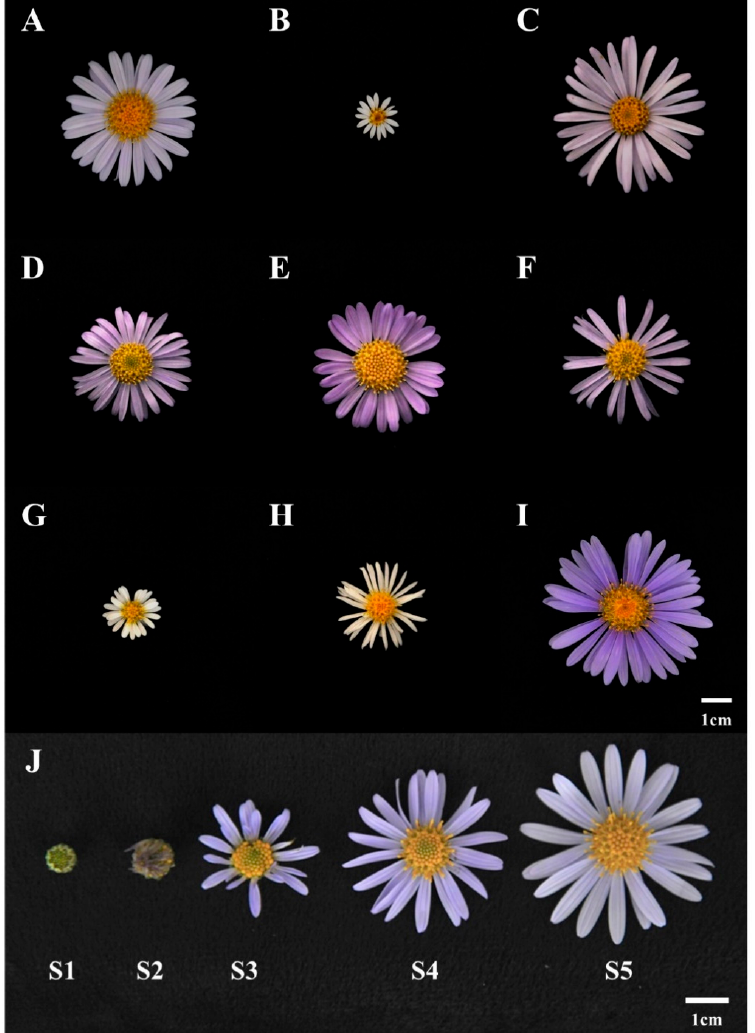
Figure 1. Flower images of nine Aster species ( A ) Aster yomena ; ( B ) Aster pseudoglehnii ; ( C ) Aster hispidus ; ( D ) Aster arenarius ; ( E ) Aster hayatae ; ( F ) Aster danyangensis ; ( G ) Aster pilosus ; ( H ) Aster maackii ; ( I ) Aster koraiensis ; ( J ) Different flowering stages of Aster yomena (stage